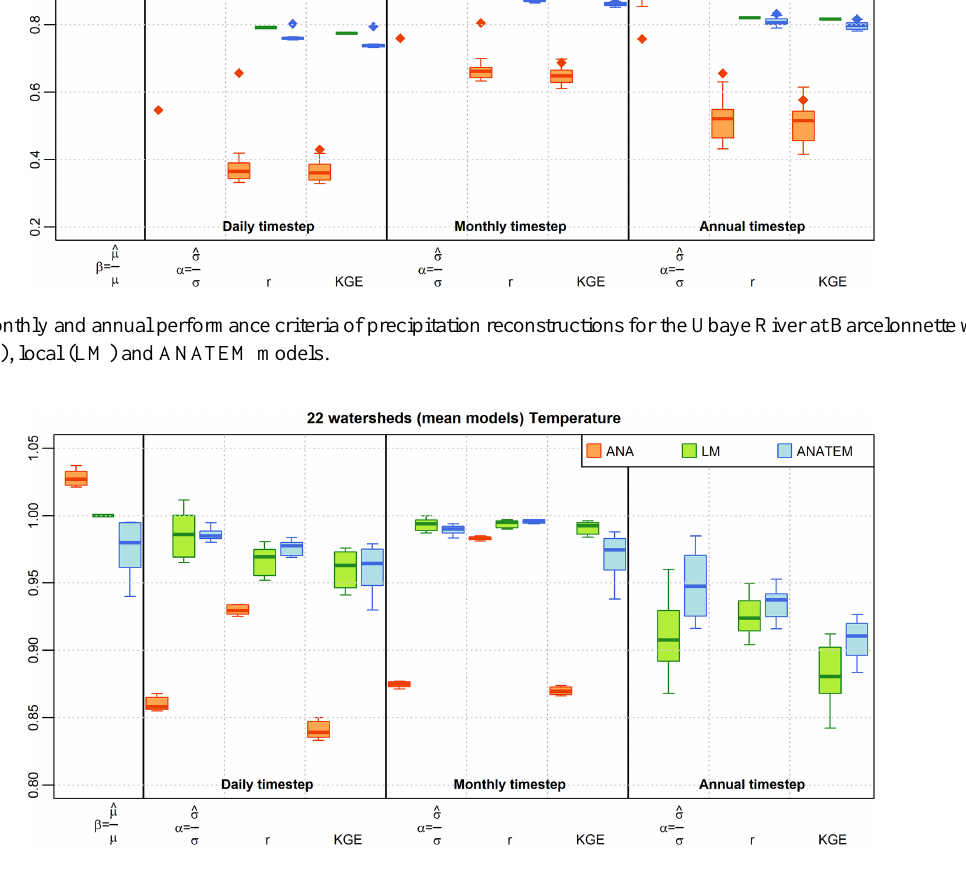
Figure 10. Daily, monthly and annual performance criteria of air temperature mean reconstructions for 22 watersheds by the analogue (ANA), local (LM) and ANATEM models. For the annual time step, ANA results are smaller than 0.6; they therefore do not appear in the